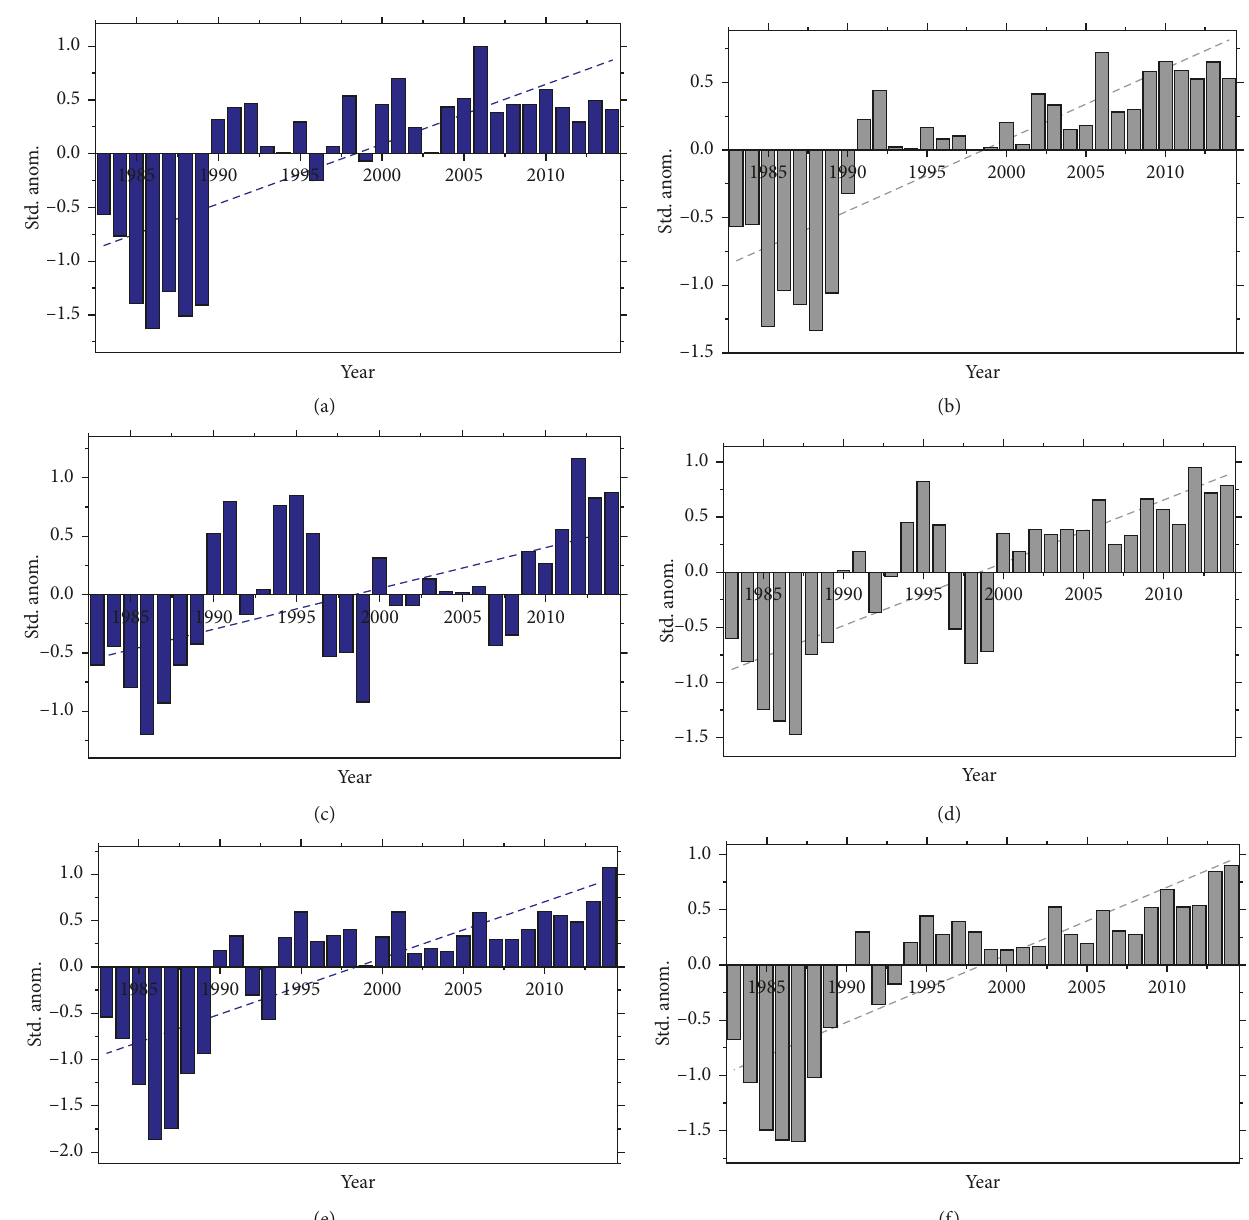
Figure 5: Standardized anomalies of the warmest night (TNx) over three agroecological zones, (a) lowland, (c) midland, and (e) highland, and for the coldest night (TNn), (b) lowland, (d) midland, and (f) highland, for the period